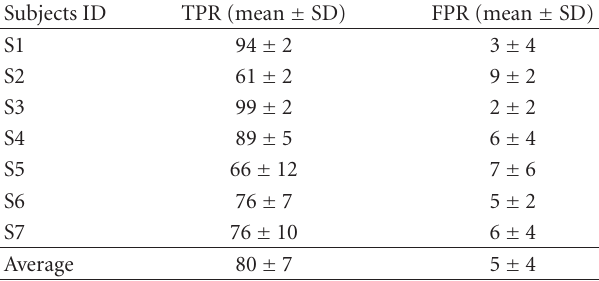
Table 3: Individual performance with optimum threshold value, dwell time, and automatic activation of